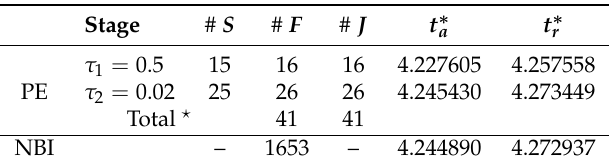
Table 3. Numerical results for minDTLZ2.